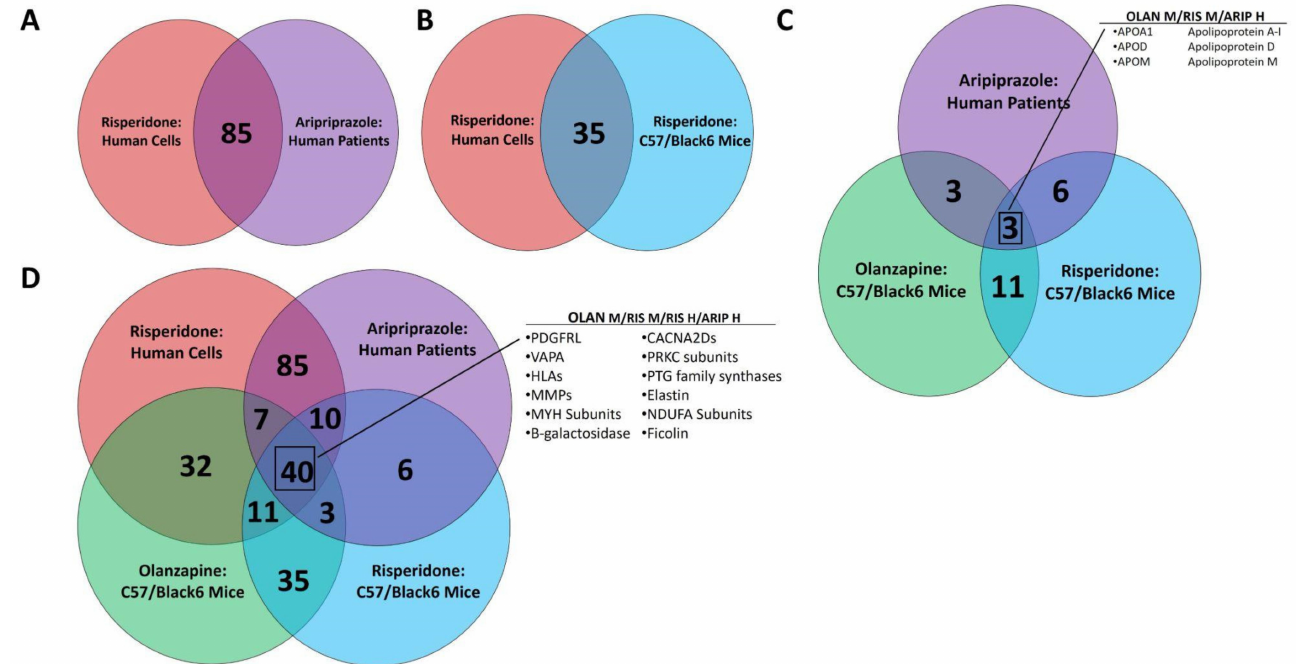
Figure 2. Differentially Expressed Traits Commonly Associated with NAFLD. Venn diagrams repre- senting overlap between AA-exposed multi-omic datasets were generated. Transcriptomic changes in psychiatric patients treated with ARIP are shown in pink, and in human neuroblastoma cells exposed to RIS are shown in purple. Proteomic changes in non-obese mice treated with OLAN are shown in green, and in those treated with RIS are shown in blue. Common changes in human systems in vitro or in vivo are shown, ( A ) as are common changes induced by RIS in vitro and in vivo. ( B ) The number of changes seen in vivo that are not seen in vitro are shown ( C ). DE traits common across study systems are shown in Panel ( D ), and those of notable interest are